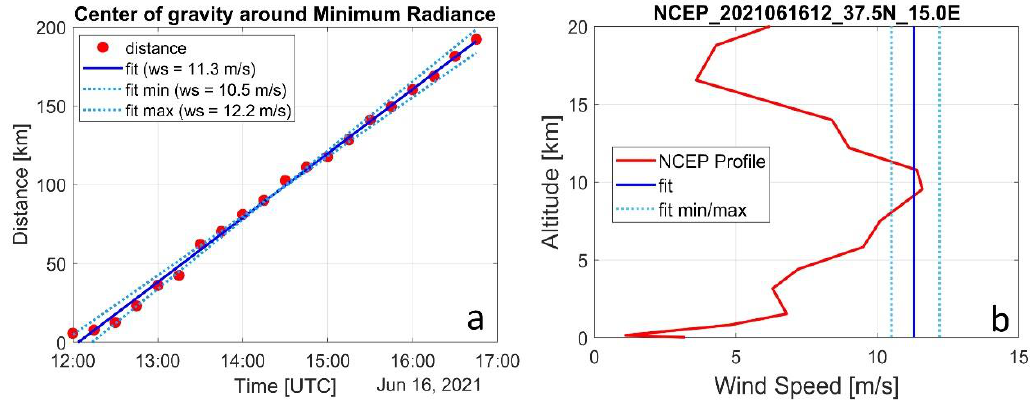
Figure 3. Example of VCTH computation using the Cloud Tracking (CT) procedure applied on the 16 June 2021 Etna lava fountain: ( a ) computation of mean wind speed ( b ) comparison with an atmospheric profile collected in the same region at the closest time.